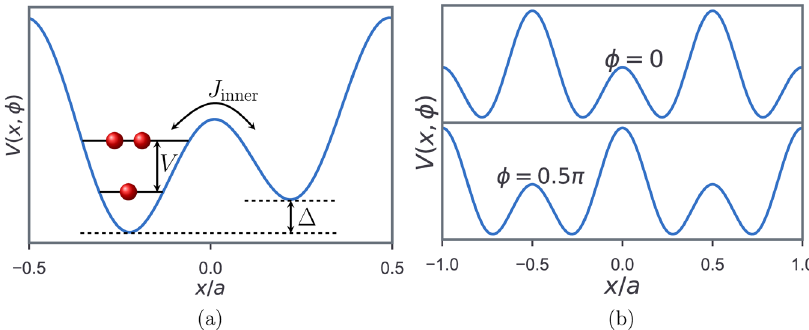
Fig. 1 The features of superlattice. a Double-well system characterized by the parameters V , J inner and Δ . b The shift of the double-well